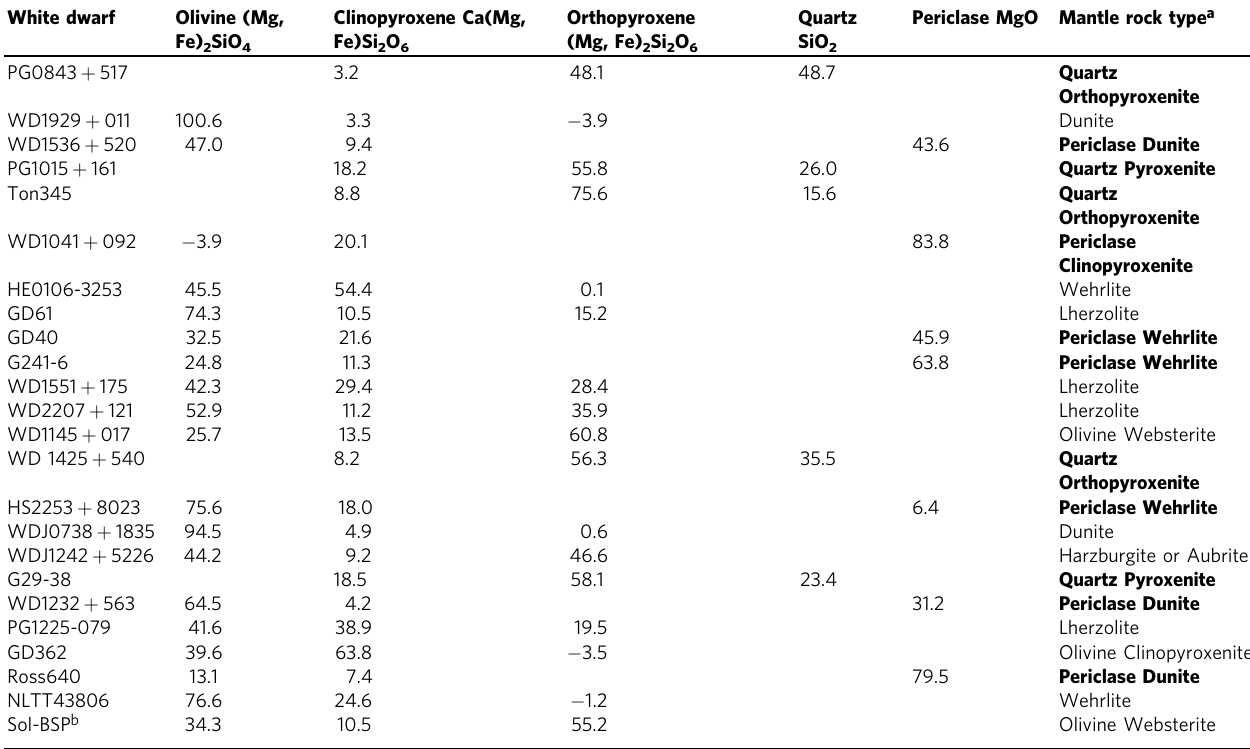
Table 1 Mantle mineral modes and rock types, calculated from bulk silicate planet compositions. White dwarf Olivine (Mg, Fe) 2 SiO